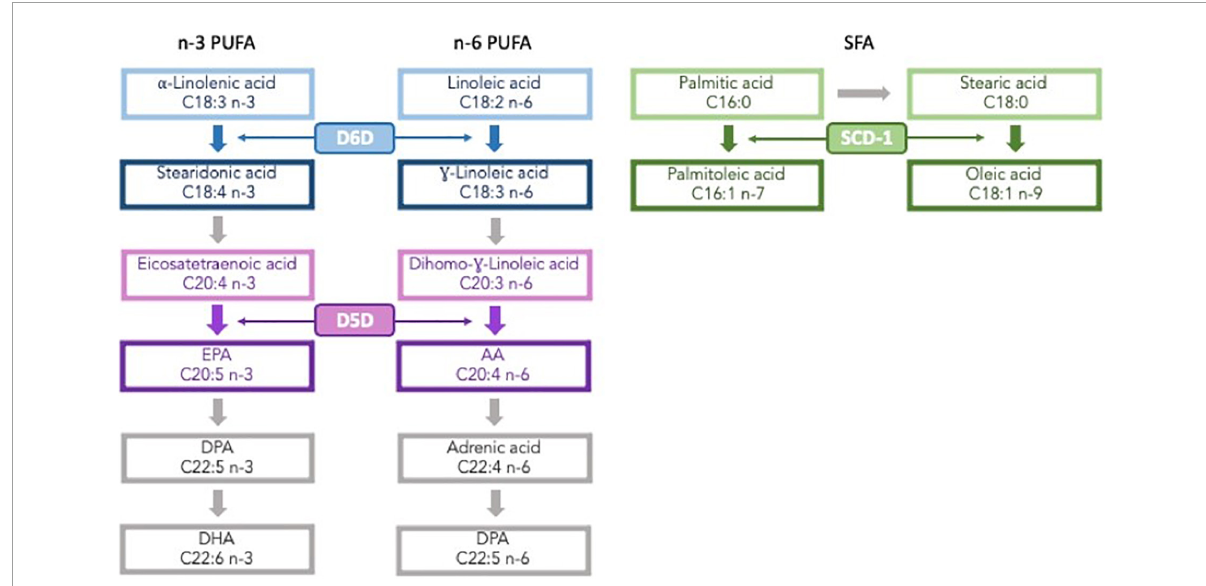
FIGURE1 Fatty acid synthetic pathway. PUFA, polyunsaturated fatty acids; D6D, D 6 desaturase; D5D, D 5 desaturase; EPA, eicosapentaenoic acid; DPA, docosapentaenoic acid; DHA, docosahexaenoic acid; AA, arachidonic acid; SFA, saturated fatty acids; SCD, stearoyl coenzyme A desaturase.